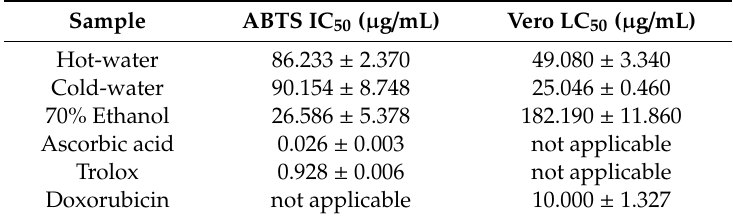
Table 1. 2,2 (cid:48) -azinobis-(3-ethylbenzothiazoline-6-sulfonic acid) (ABTS) radical scavenging activity of the extracts and their cytotoxicity e ff ect on Vero cells.